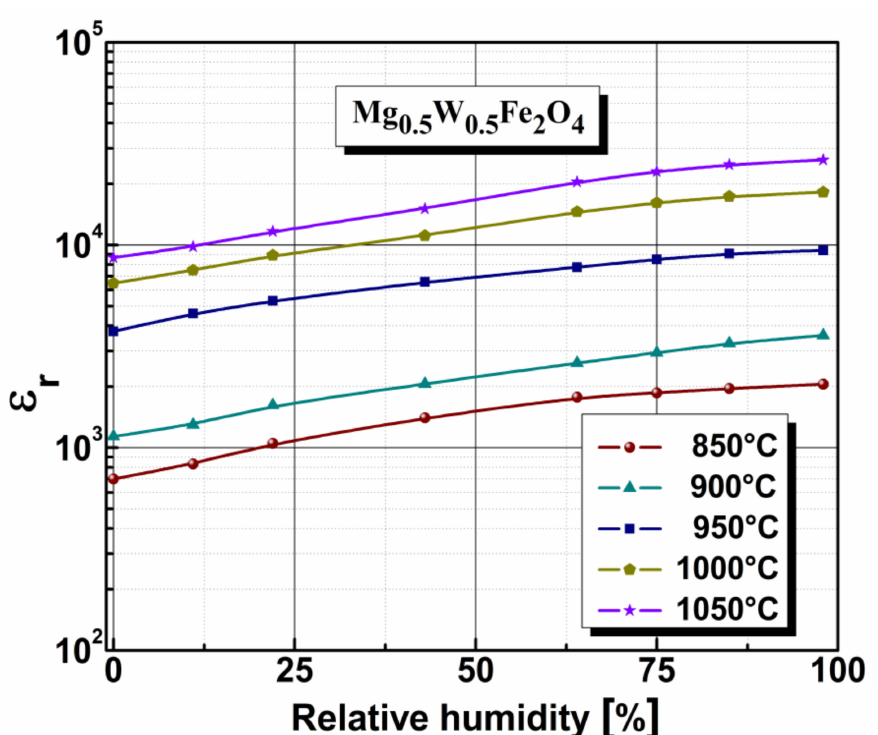
Figure 7. Relative permittivity under different humidity conditions for Mg 0.5 W 0.5 Fe 2 O 4 ferrite.